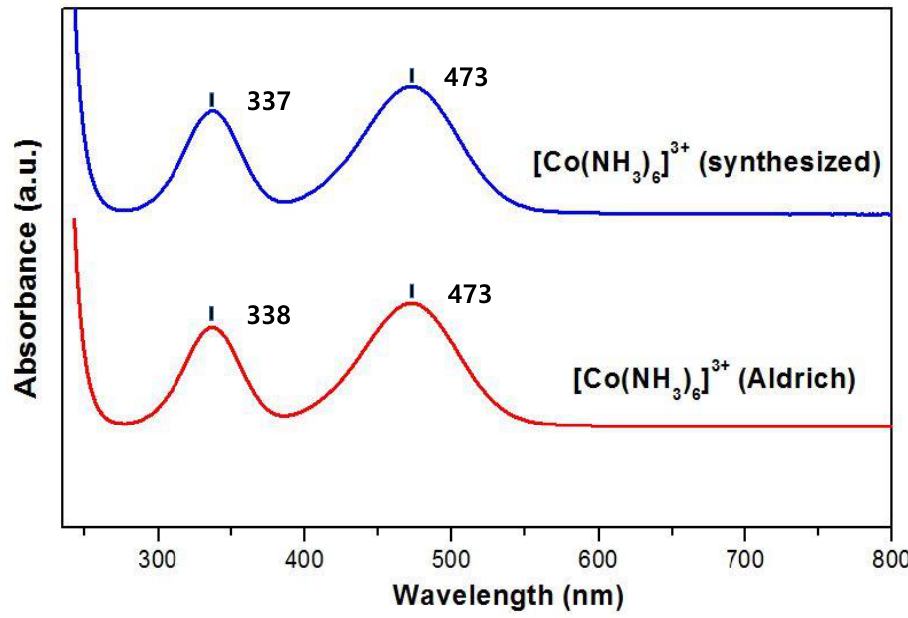
Figure 4. UV–Vis absorption comparison between the commercially available hexaamminecobalt(III) (red) and synthesized hexaamminecobalt(III) cation (blue).